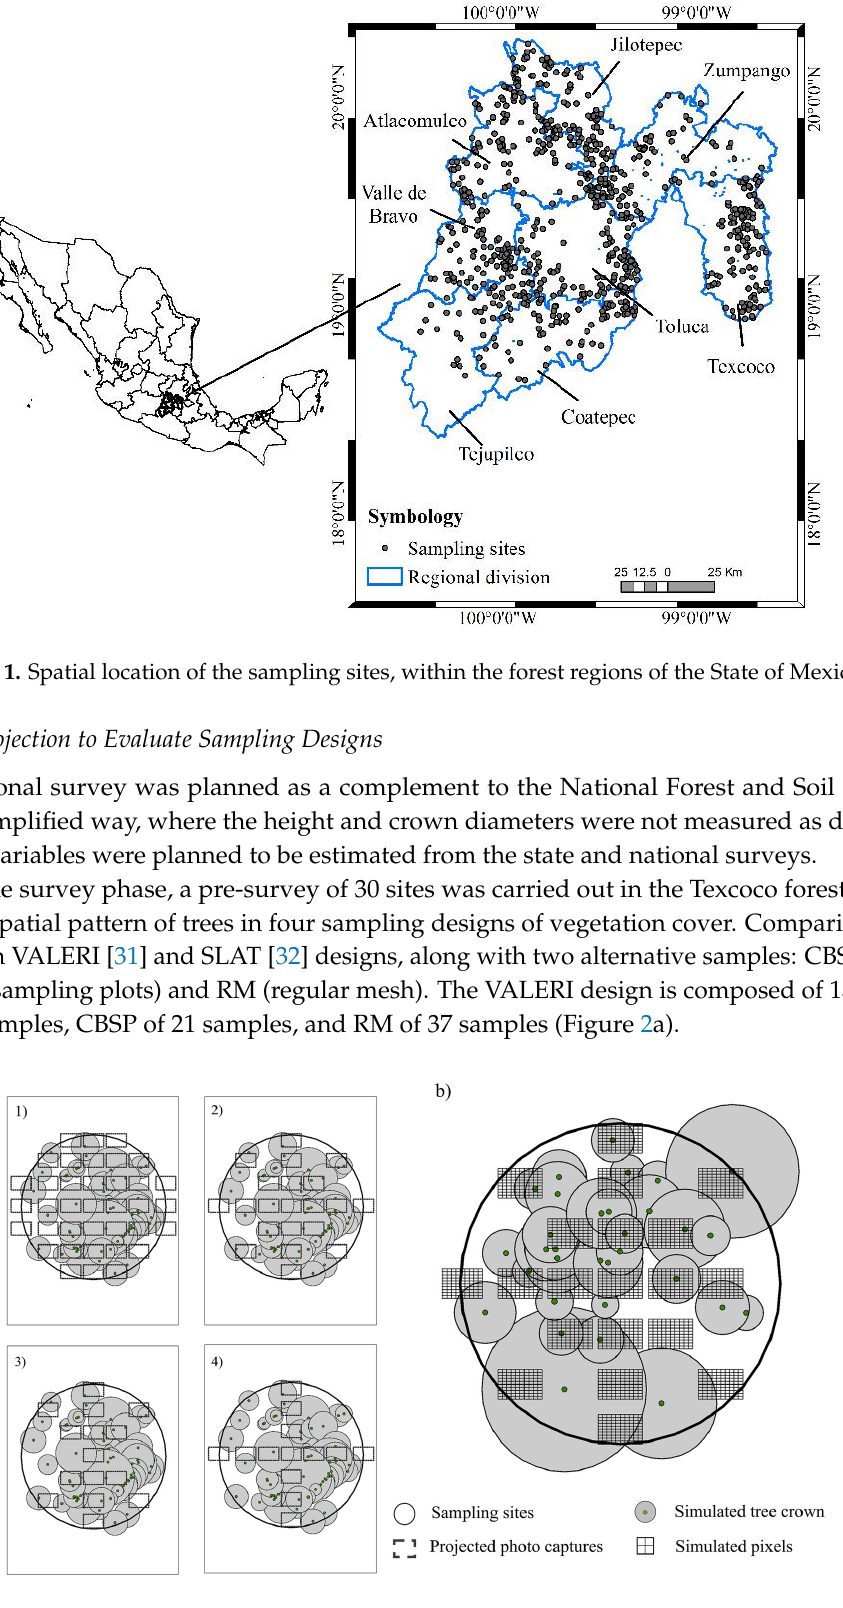
Figure 2. ( a ) Photographic captures by sampling design: (1) RM, (2) CBSP, (3) SLAT, (4) VALERI; ( b ) Projected photo capture areas (pixels) in a CBSP sampling design.